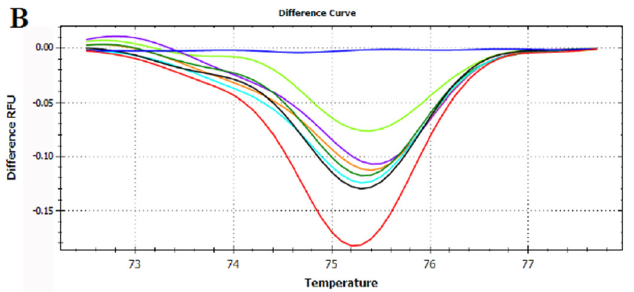
Figure 9. Normalized melt curve ( A ) and difference curve ( B ) of HRMA of P6 loop of trnL (UAA) intron on DNA blends of apple and peach. Apple fruit: red, peach fruit: blue, apple/peach DNA mixes 99.5%/0.5%: black, 99%/1%: light blue, 95%/5%: green, 90%/10%: orange, 75%/25%: purple and 50%/50%: light green. Reference cluster is peach fruit: blue. The HRMA has been carried out on three independent replicates of each sample and the most representative curve of each sample is reported in the graph.